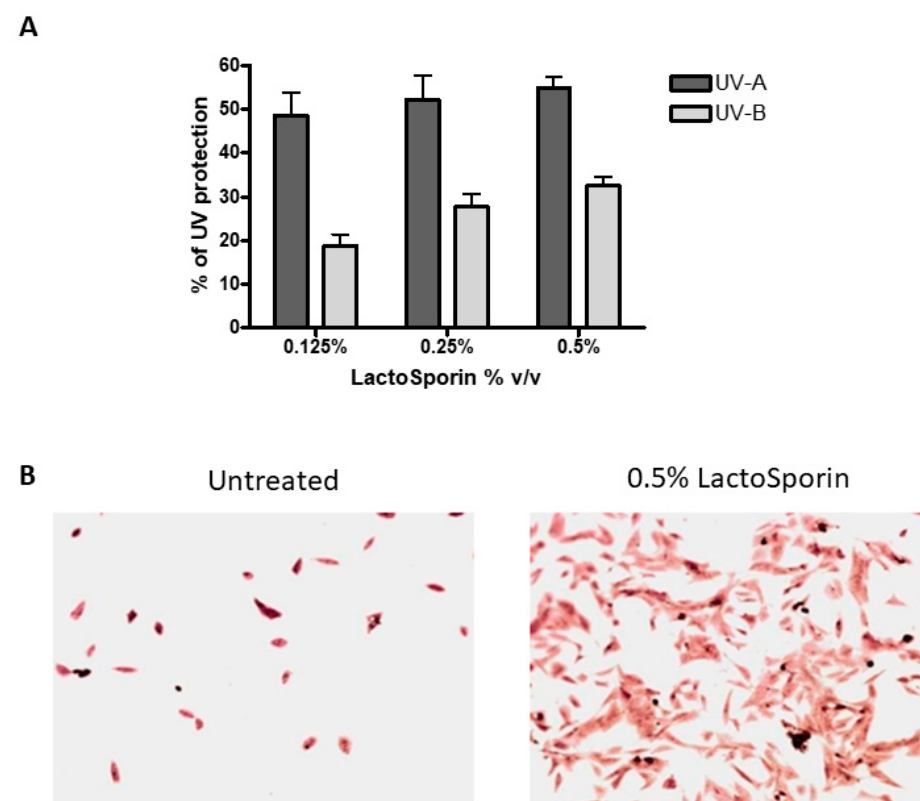
Figure 2. ( A ). Percentage protection of LactoSporin against UV-A- and UV-B-induced cell death, ( B ). UV-B irradiated BALB/3T3 cells, treated with 0.5% LactoSporin, stained with Crystal violet (20×). Data ( B ). UV-B irradiated BALB / 3T3 cells, treated with 0.5% LactoSporin, stained with Crystal violet (20 × are represented as Mean ±SD, n = 3.